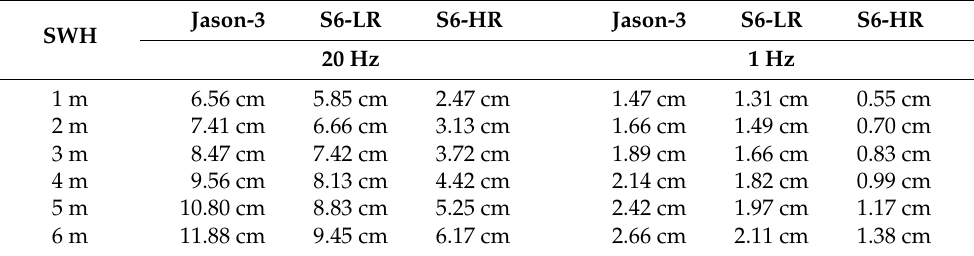
Table 3. The noise levels of Jason-3 and Sentinel-6 (S6) estimated using the differential method. Jason-3 S6-LR S6-HR Jason-3 S6-LR S6-HR SWH 20 Hz 1